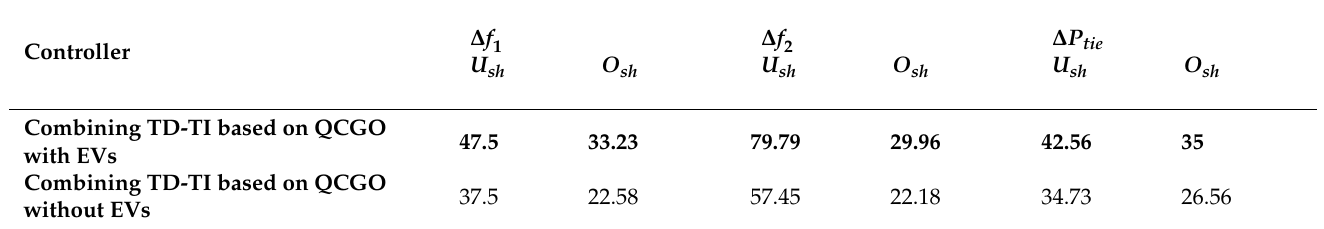
Table 23. Percentage improvement in U sh and O sh values for combining TD-TI/QCGO and combin- ing TD-TI/CGO based on combining TD-TI/SSA for scenario